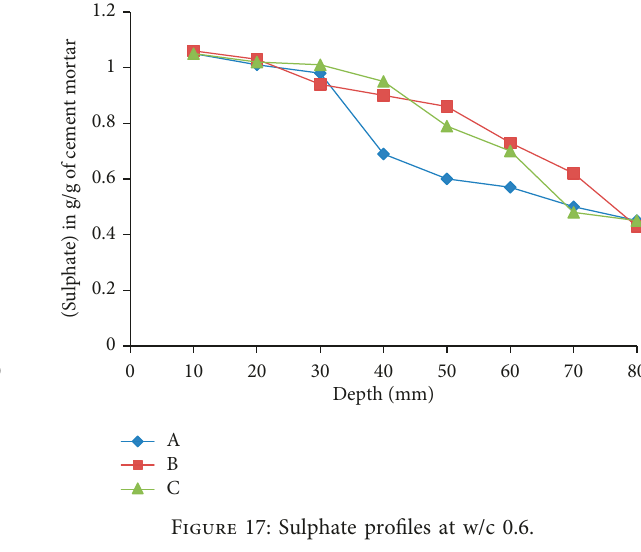
Figure 15: Chloride profiles at w/c 0.7.